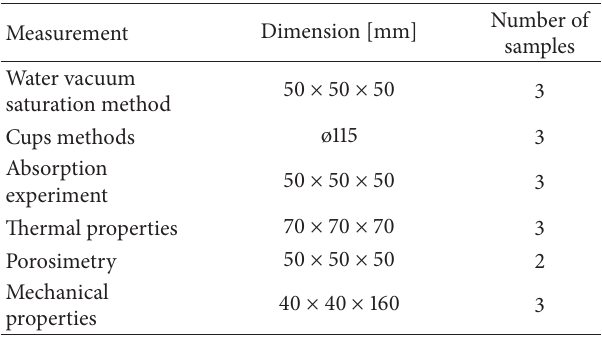
Figure 1: Granulometry curves of three types of coir pith. Table 5: List of